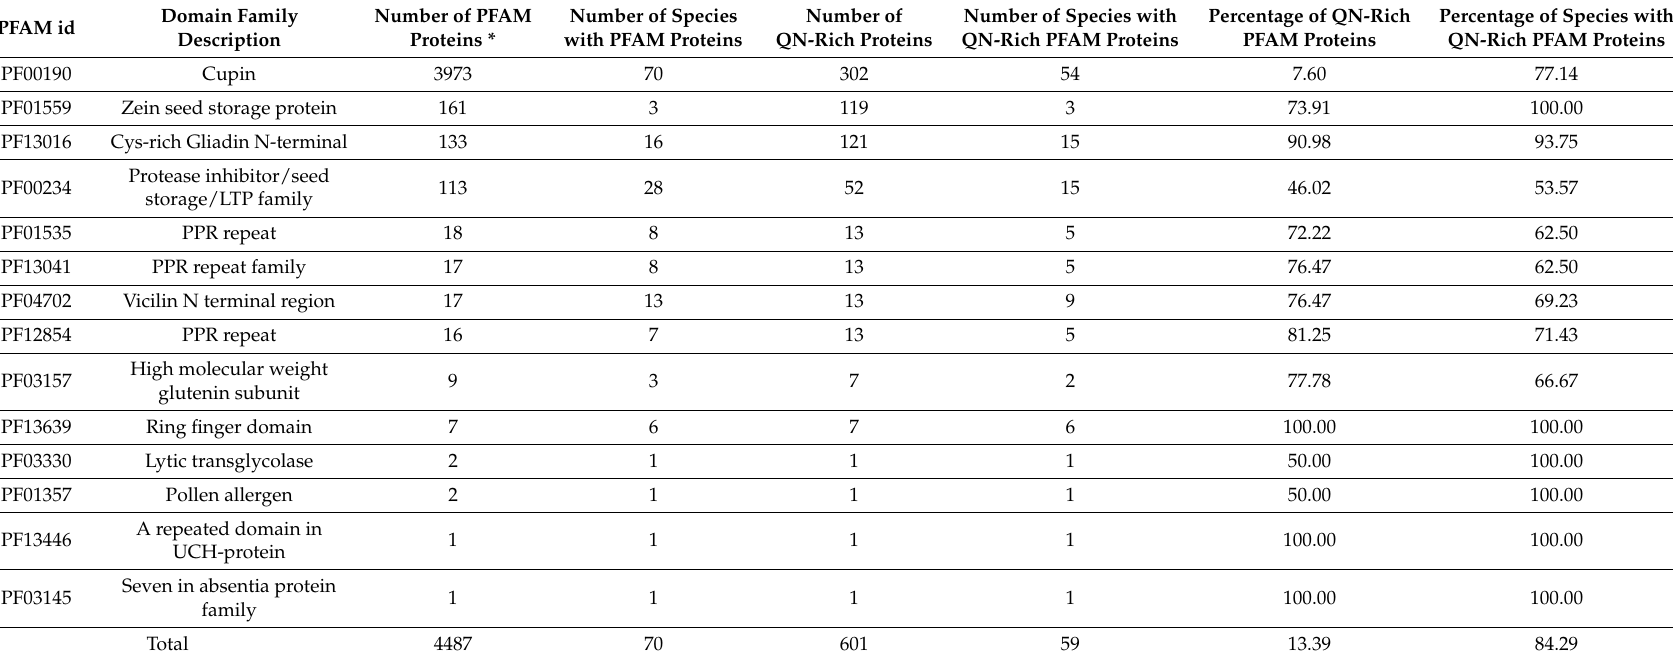
Table 1. Distribution of the potentially amyloidogenic QN-rich storage proteins across the plant